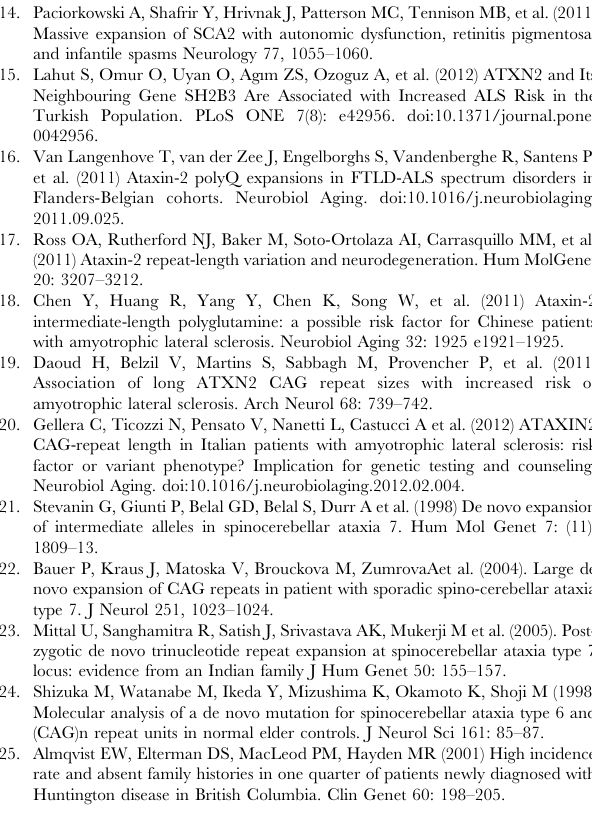
Table S1 Major Mutations in ATXN2-ALS case